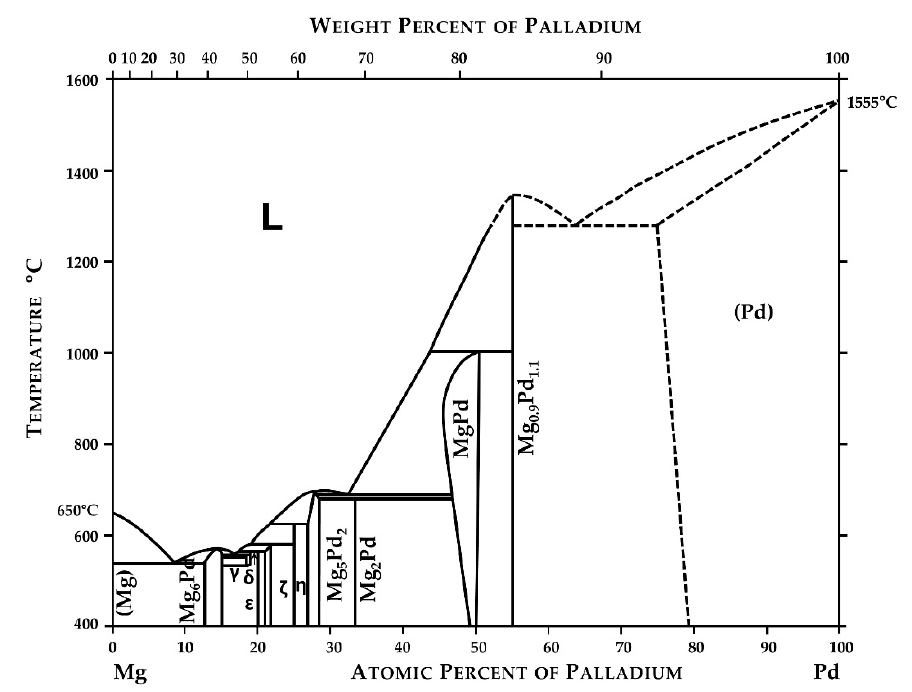
Figure 1. Phase diagram of the Mg-Pd system. Reprinted with permission from ref. [33]. 2010, Springer Nature.